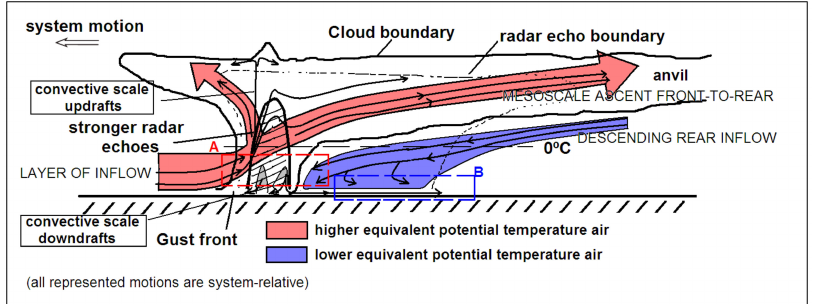
Figure 3. A conceptual model of a kinematic, microphysical and radar echo structure of a convective line MCS with trailing-stratiform precipitation as viewed in a vertical cross-section at an angle perpendicular to the convective line with a westward propagation. Dark grey shades indicate stronger radar reflectivity. Area A (dashed red) highlights the region where the front-to-rear inflow and the rear-to-front mid-level inflow (RTF) converge. Area B (dashed blue) highlights the region where the low-level front-to-rear flow beneath the RTF is observed (adapted from Reference [23]. © American Meteorological Society. Used with